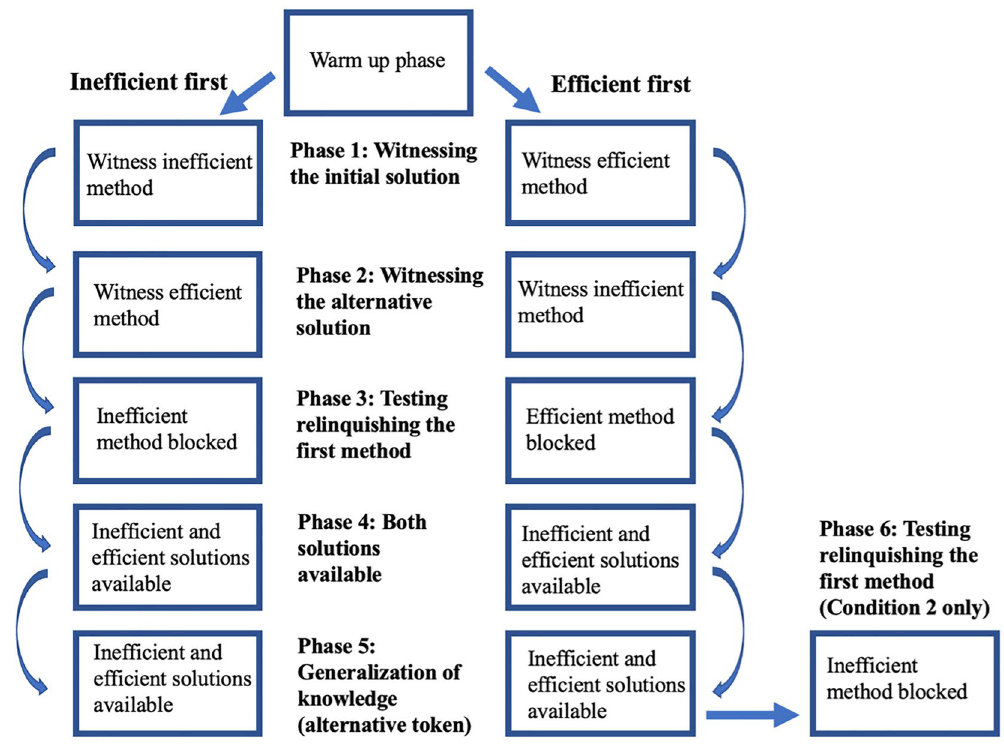
Figure 3. Breakdown of the experimental